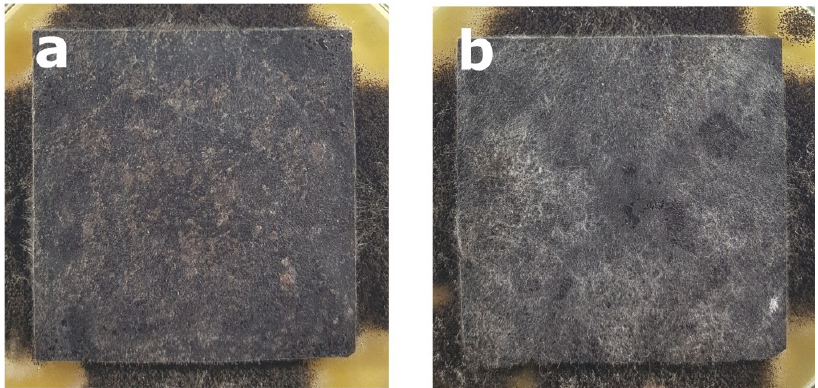
Figure 4. Example of mold growth ( Aspergillus niger Tiegh) after 7 days of exposure of composite samples with small particle bark filler of 60%, based on a matrix: ( a ) HDPE; ( b ) PLA.